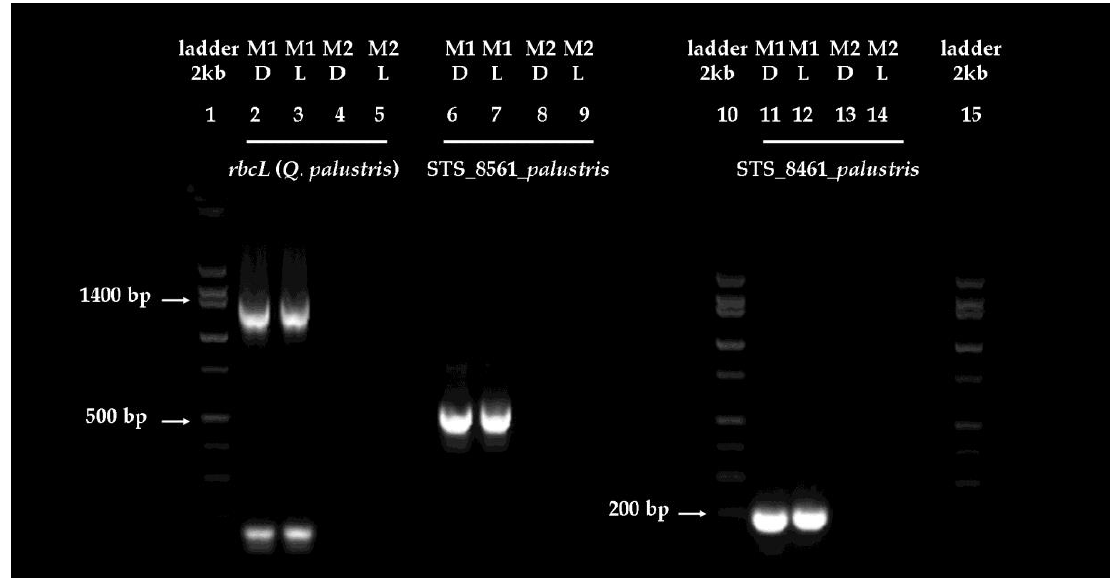
Figure 3. Amplification of selected target gene fragments from DNA extracted from in situ dark- or light-adapted mature pin oak ( Q. palustris ) leaves. The figure shows a representative example of PCR amplification of the 1300 bp rbcL , 500 bp STS_8561_ palustris and 209 bp STS_8461_ palustris sequence tagged site segments from dark- (D) and light-adapted (L) leaves, using extraction method M1 and M2, on a 2% agarose gel containing 0.5 µg/mL ethidium bromide. The low molecular weight bands (at about 175 bp) in the lane showing the amplified rbcL segment (M1D and M1L) are non-specific amplification products. A 2 kb DNA ladder was used for fragment sizing. Arrows indicate the position of the 1400, 500 and 200 bp bands in the marker line. To establish whether there is a quantitative difference between the efficiency of the amplification of fragments, apparent bands were excised from the gel and the DNA purified and quantified from the excised fragments. Yields of the 1300 bp rbcL amplicon fragments were of 325 and 227.6 ng, 500 bp STS_8561_ palustris of 375 and 388 ng and 209 bp STS_8461_ palustris of 420 and 426 ng, for dark- and light-adapted samples, respectively. No bands were observed for any of the samples using as template the DNA isolated by method M2, suggesting no amplification of the target gene fragments. Abbreviations stand for: D = dark-adapted; L = light-adapted; M1 = method 1; M2 = method 2.